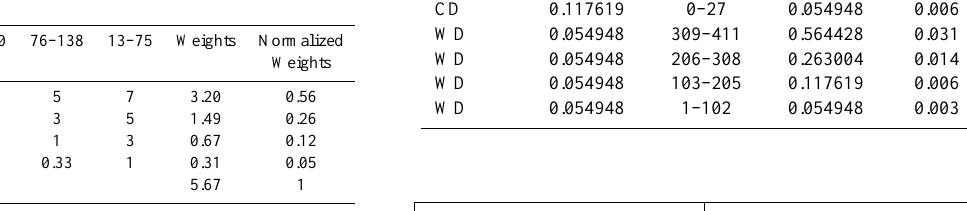
Table 3. Weighting of four classes of Heat Index.